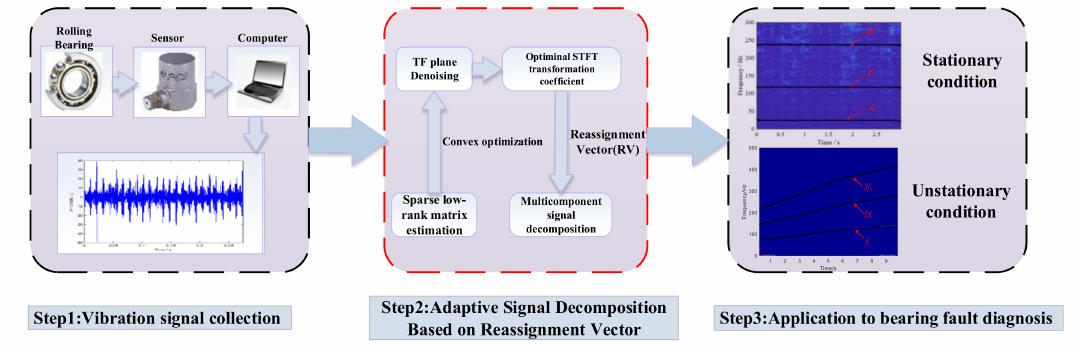
Figure 1. The flowchart of the proposed